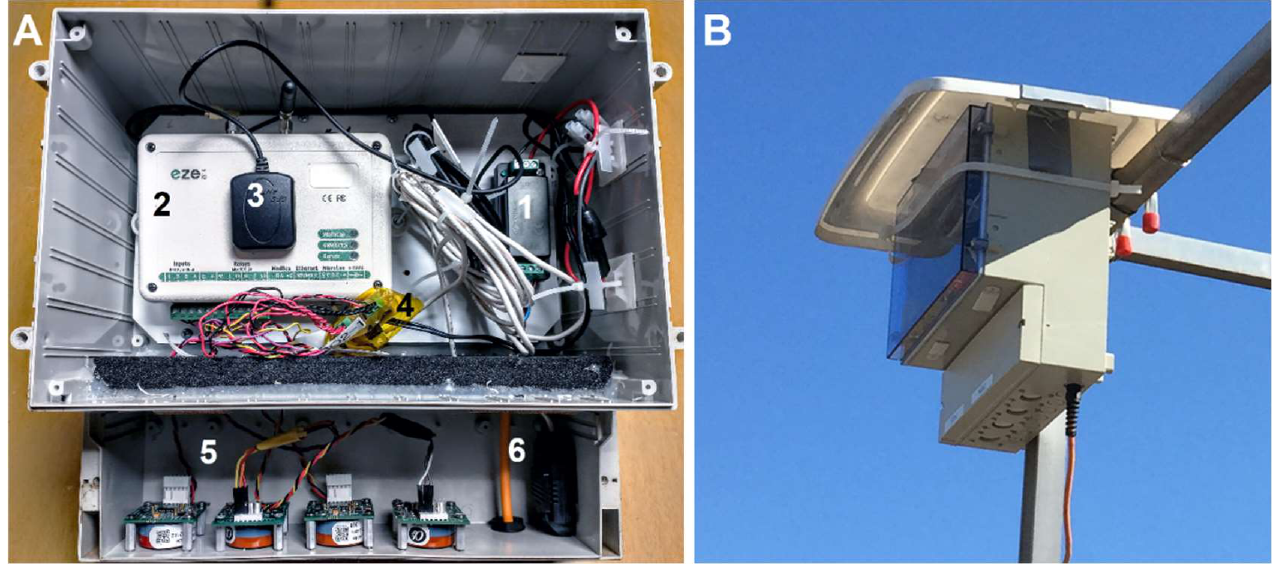
Figure 4. ( A ) Sensor module assembled inside the IP box. 1: Voltage transformer, 2: IoT microcon- troller, 3: GPS, 4: T-RH sensor, 5: low-cost electrochemical sensors for SO 2 and NO 2 , 6: power cable. ( B ) Sensor module deployed in the field.